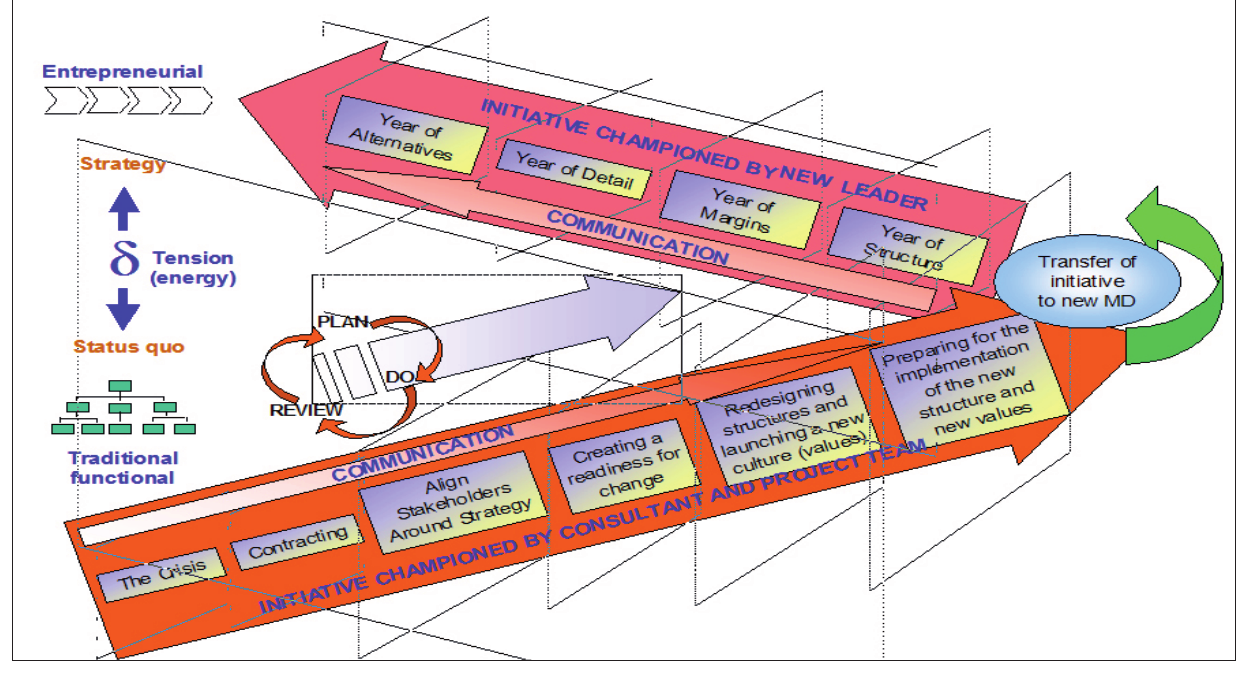
Figure 1 A conceptual framework for organisational